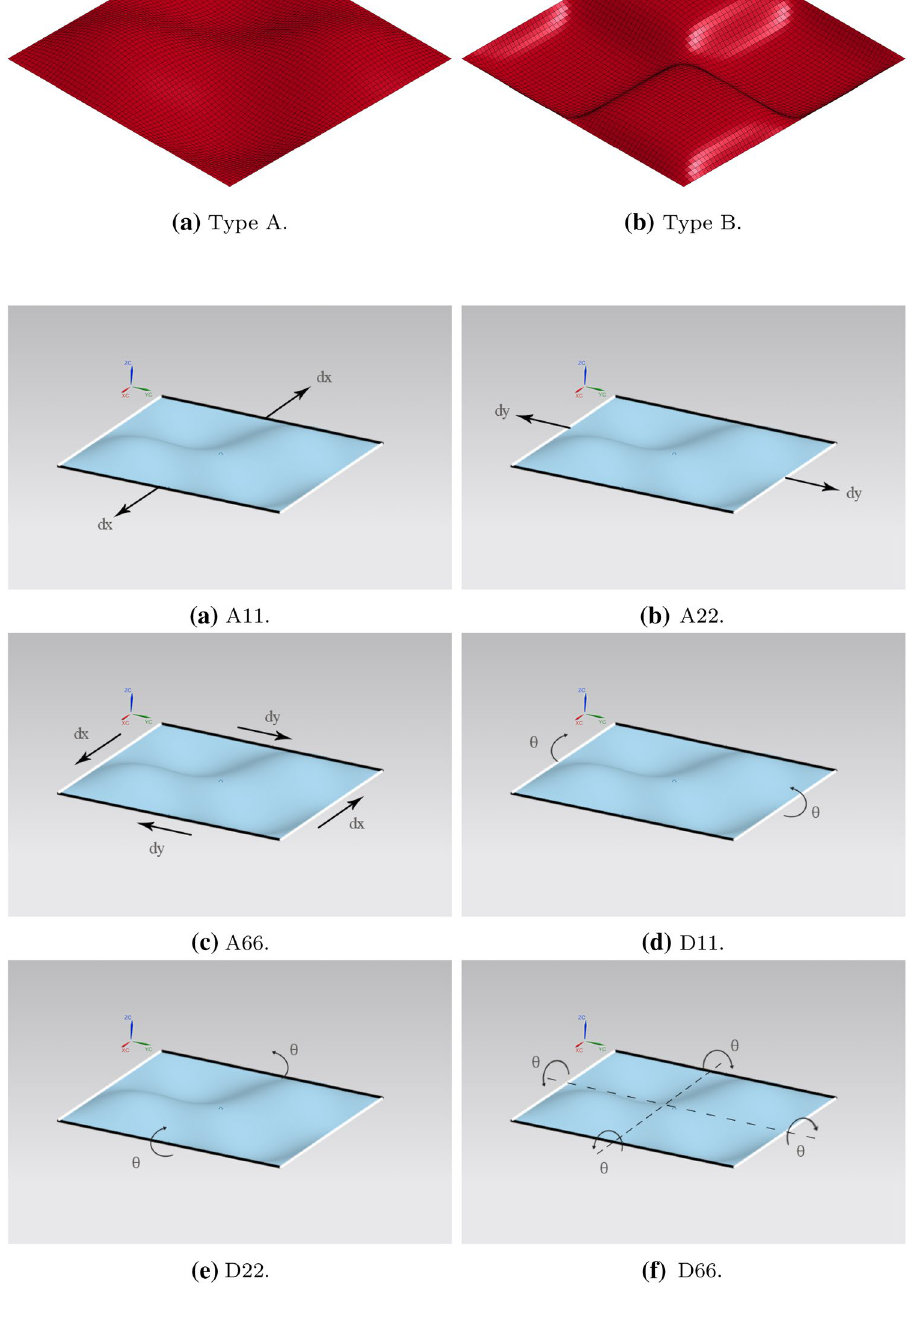
Fig. 7 Representative volume elements (RVEs) used for mechanical characterization of core